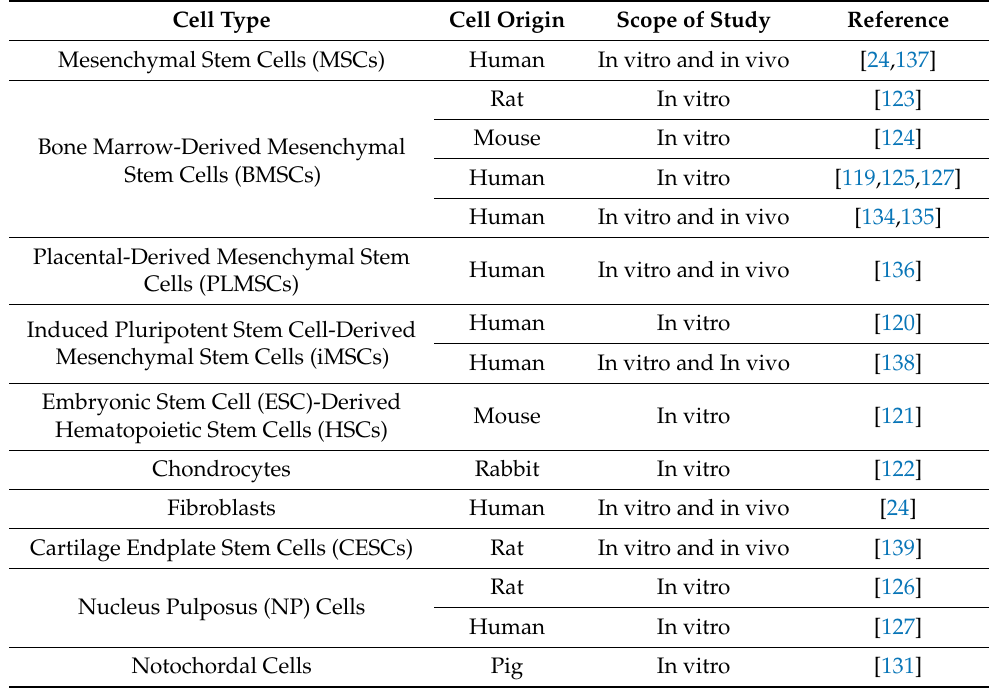
Table 1. Stem cell-derived exosomes for IVDD therapy referenced in this